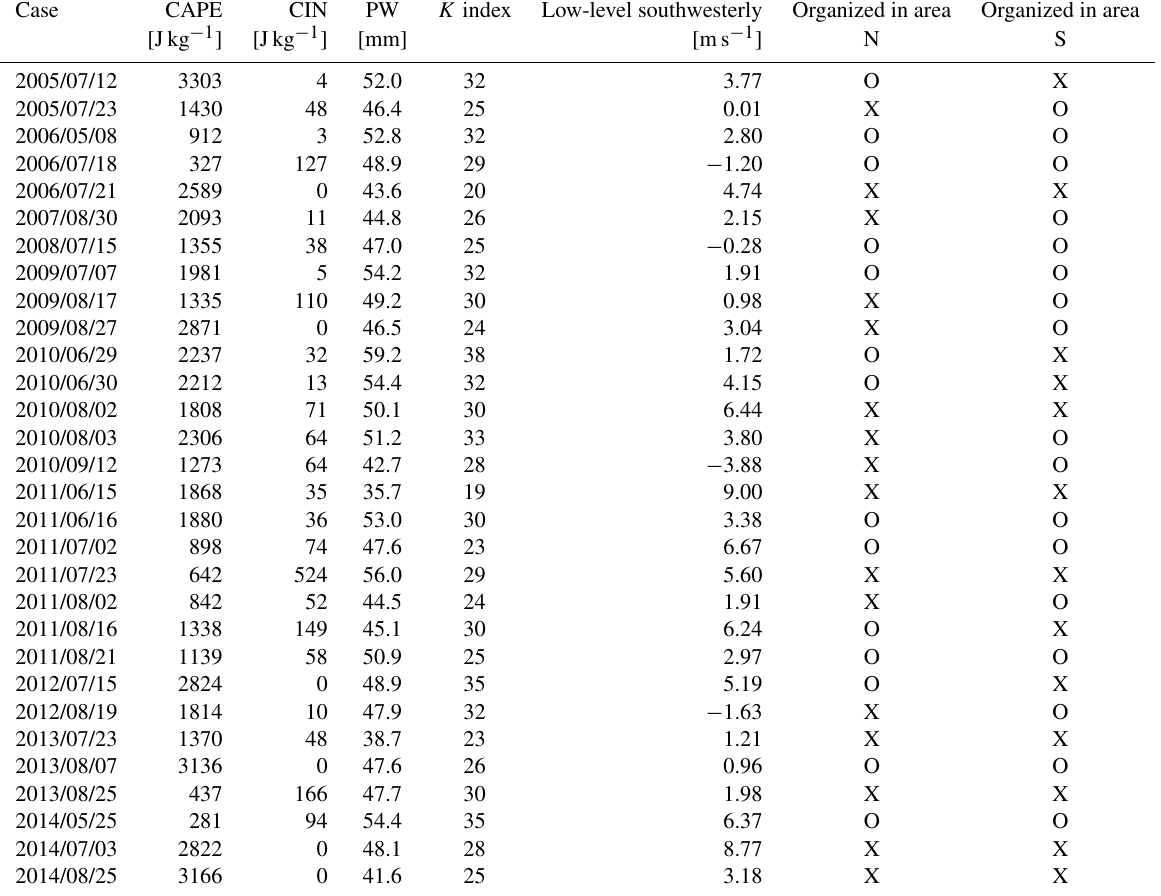
Table A1. The thermodynamic and dynamic parameters of the 30 initial soundings. Dates are in the format year/month/day. The organization status is also listed in the table, presented by O (organized regime) and X (non-organized